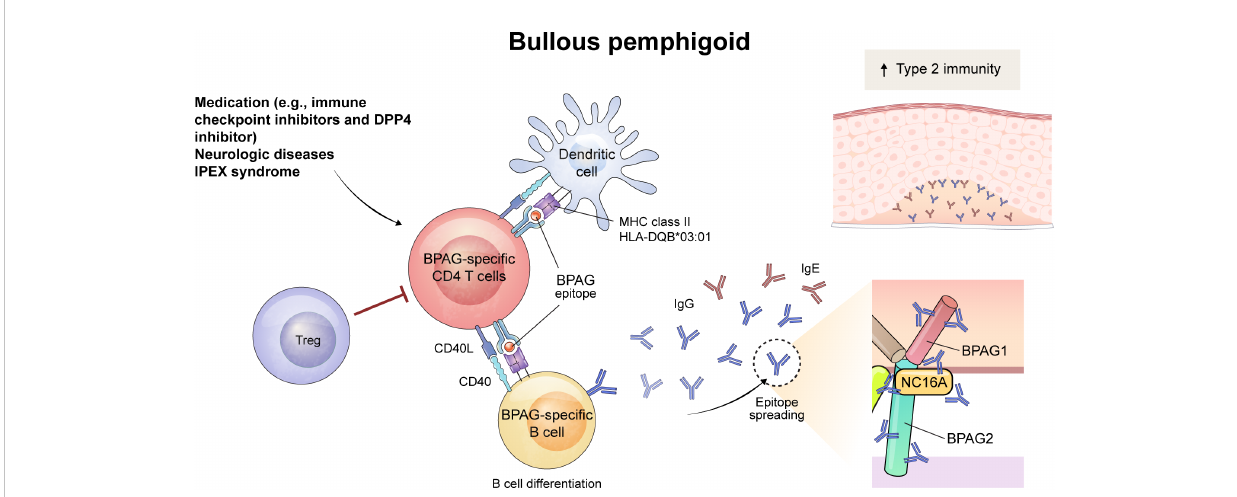
FIGURE 2 Schematic overview of immune mechanism of BPAG-speci fi c CD4 + T cells in bullous pemphigoid (BP). The triggering factor for BP can be medication (e.g., immune checkpoint inhibitors and dipeptidyl peptidase-4 inhibitor) or neurologic diseases. The process begins with the presentation of a BPAG epitope by dendritic cells through MHC class II, including HLA-DQB*03:01, which activates BPAG-speci fi c CD4 + T cells. Also, dysfunction of Treg cells play a role in the development of BP, as evidenced in patients with IPEX syndrome. This leads to interaction with BPAG-speci fi c B cells through CD40-CD40L interaction, resulting in the differentiation of B cells and the epitope spreading of IgG and IgE autoantibodies. Among them, NC16A domain of BPAG2 is recognized as a major pathogenic epitope of autoantibodies. These autoantibodies bind to the basement membrane zone of the skin and mucous membranes, inducing subepidermal blistering in BP. The increased type 2 immunity was seen in BP and might contribute to the development of the